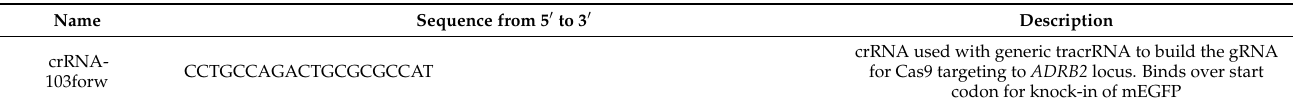
Table 1. List of crRNAs, HDR donors and primers used for genotyping and